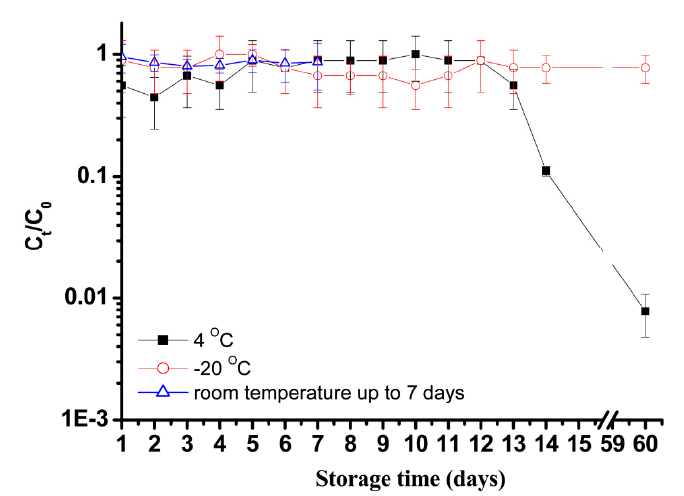
Figure 2. Stability of ϕ BTCU-1 stored in phage buffer at − 20 °C and 4 °C. ϕ BTCU-1 stability at room temperature (25–27 °C) was also evaluated, although it was only stored for 7 days. The vials used in this test were all discarded and never refroze again. These experiments were repeated three times and the data shown are the mean ± standard error of the mean.